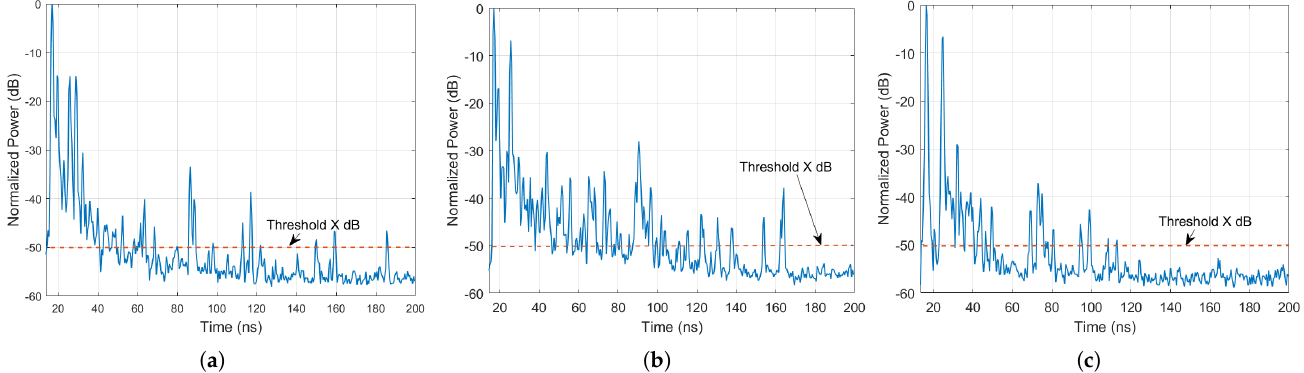
Figure 6. Normalized power delay profile at a 5 m Tx-Rx separation distance in ( a ) the Manufacturing hall at Dokka Fastners AS, ( b ) the Test room at Dokka Fastners AS, and ( c ) NTNU